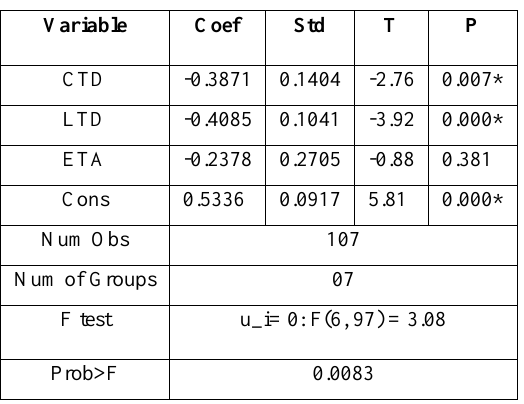
Table 6: Breusch Test